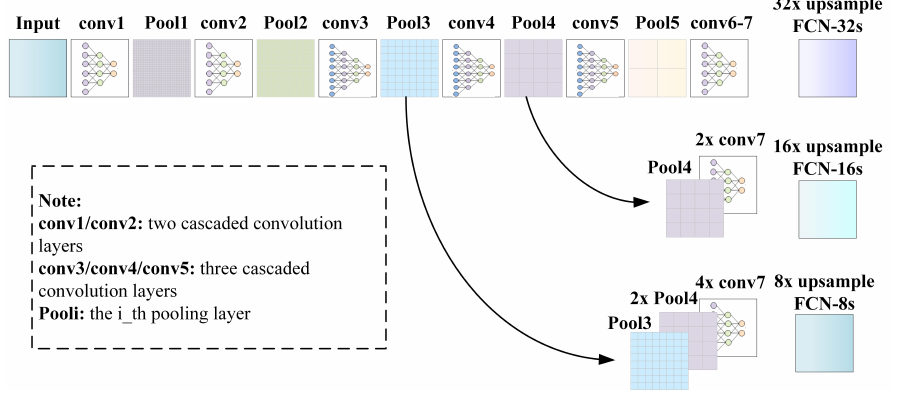
Figure 2. Architectures of Fully Convolutional